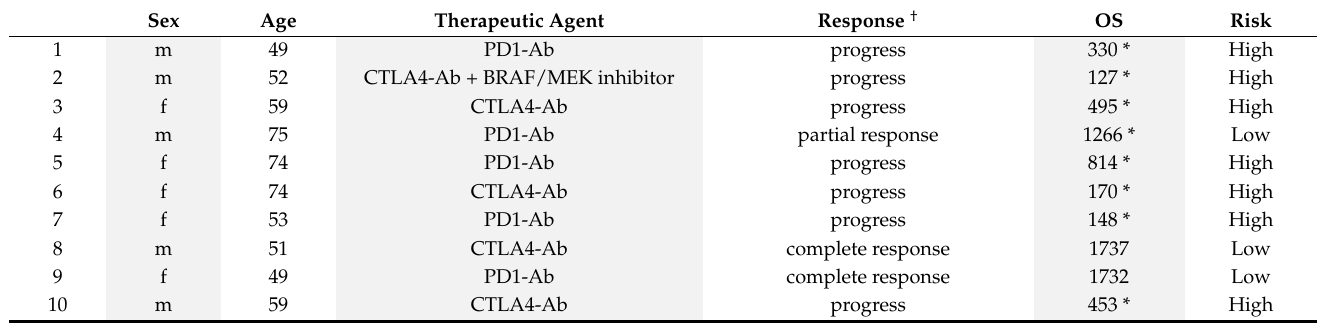
Figure 3. Flowchart for patient selection. From a cohort of 62 patients, 37 patients were selected based on the inclusion criteria. Table 1. Patient